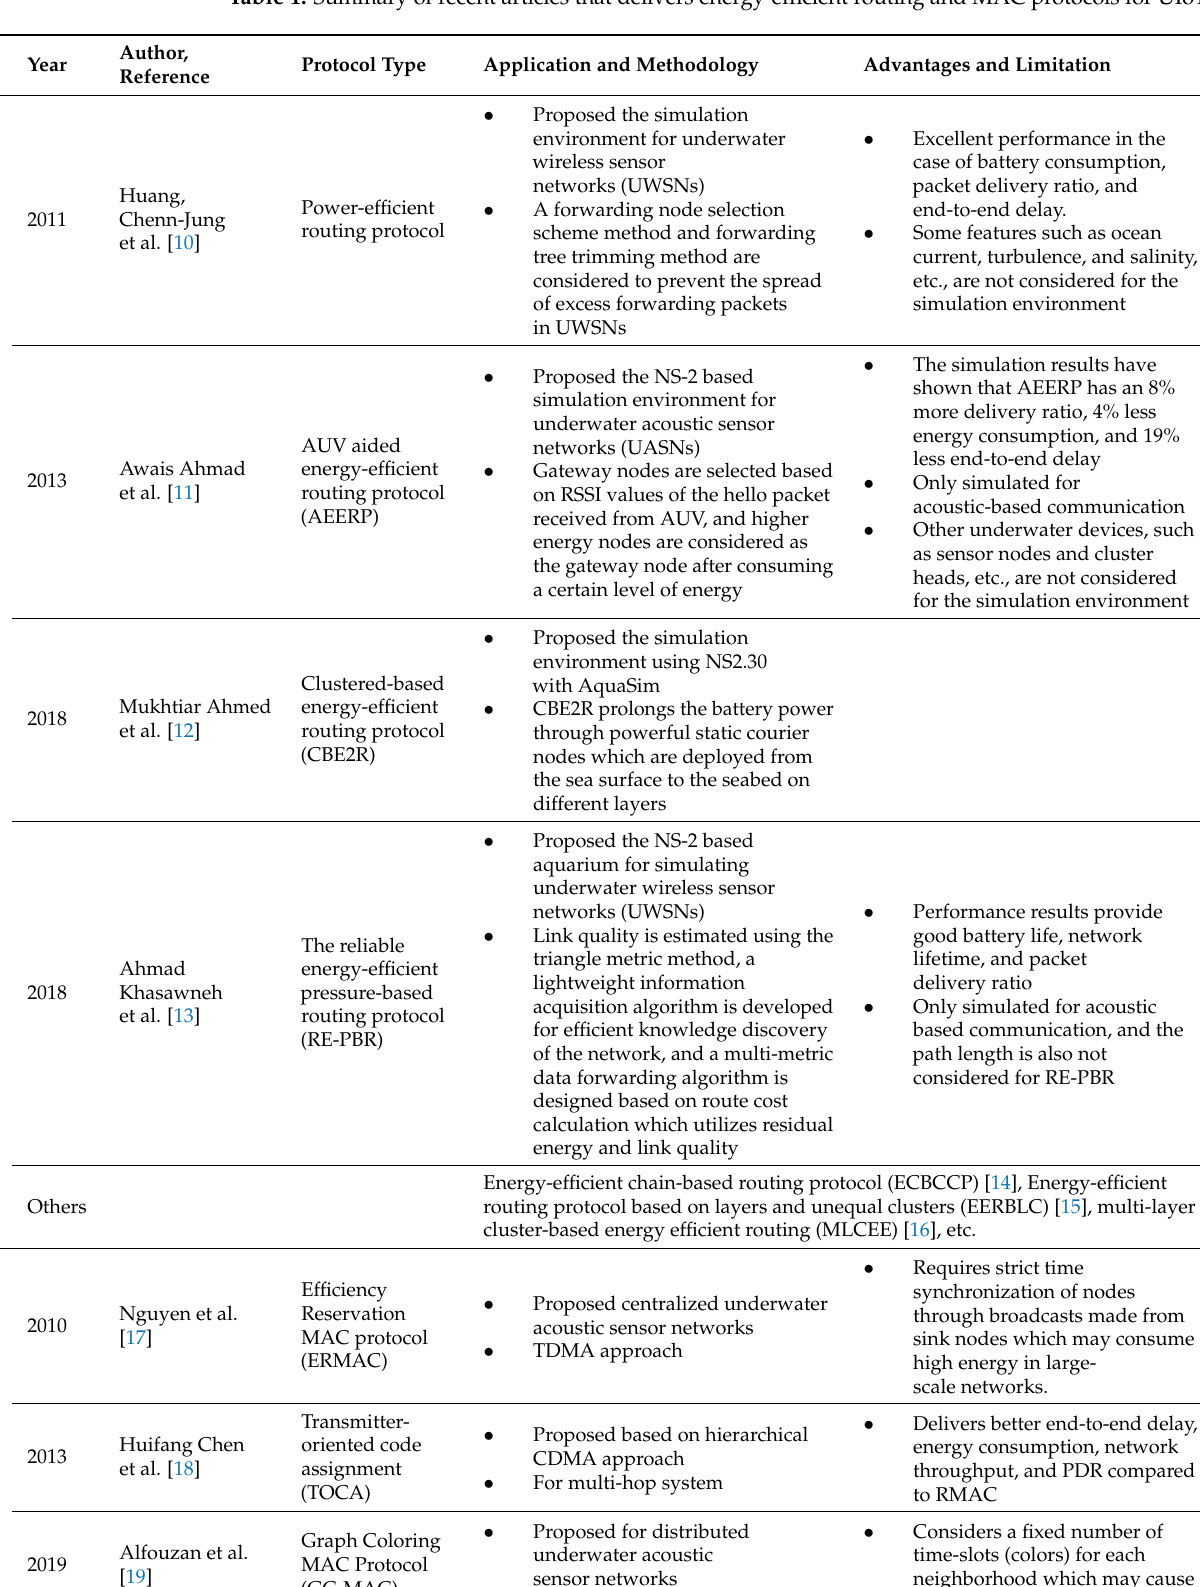
Table 1. Summary of recent articles that delivers energy-efficient routing and MAC protocols for